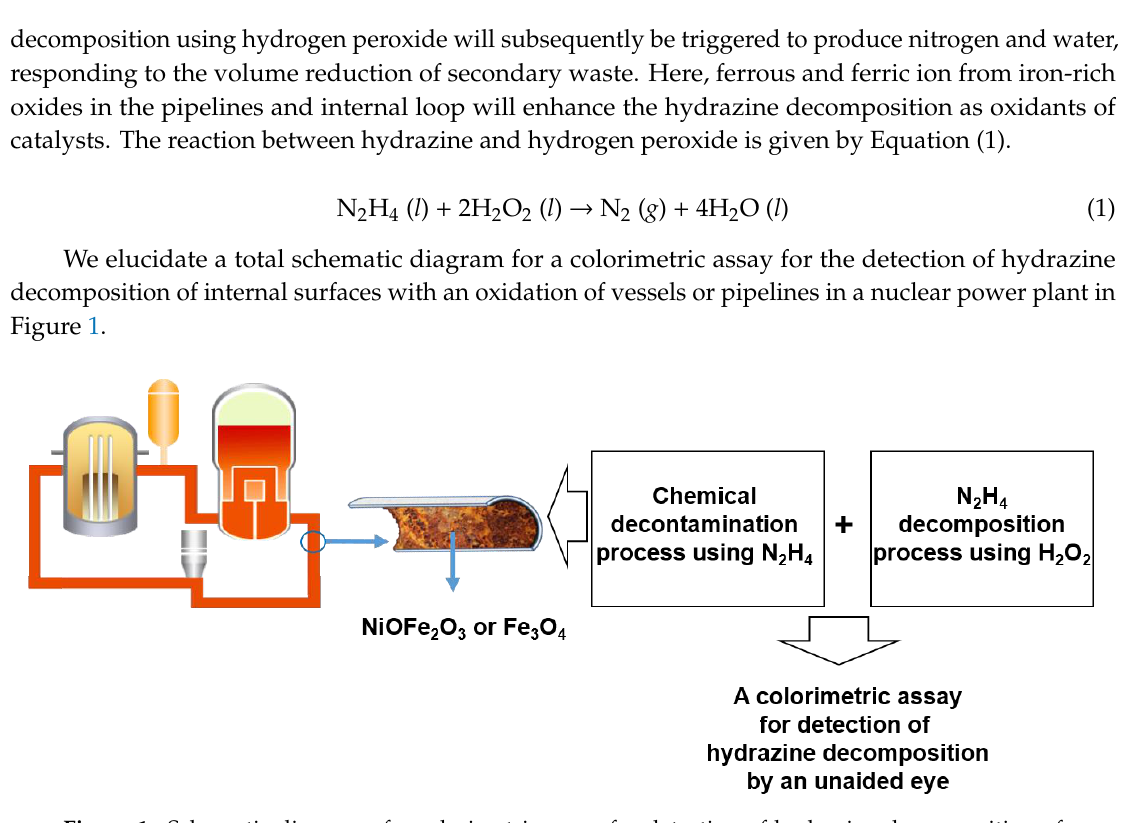
Table 1. Properties and chemical structure of hydrazine.